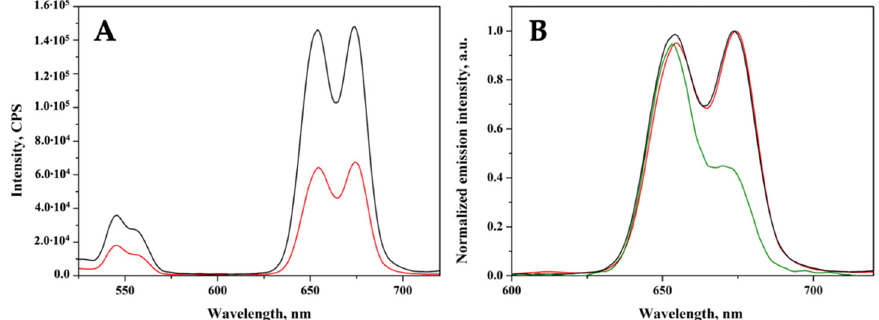
Figure 7. ( A ). UC emission spectra of ZEY2 (curve a, red) and ZEY2@SiO 2 (curve b, black); ( B ). Nor- malized UC emission spectra of ZEY2 (red curve), ZEY2@SiO 2 (black curve), and ZEY2-Ver (green curve).